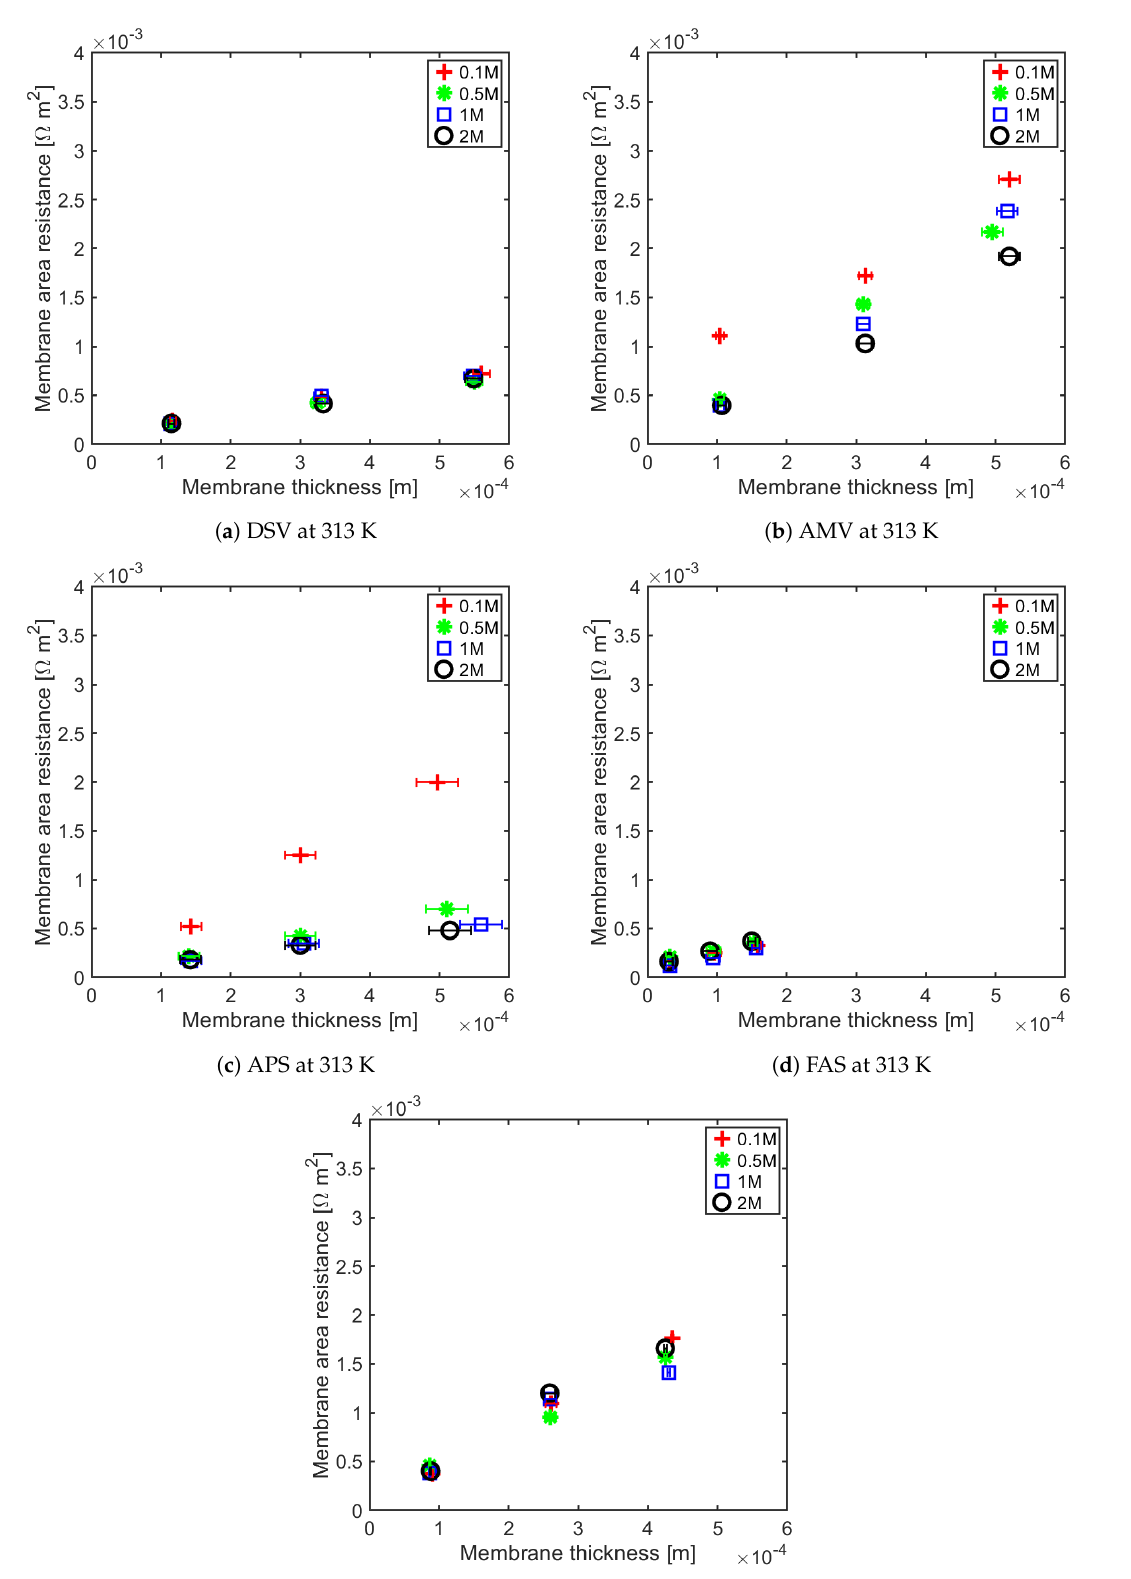
Figure 6. AEM resistance as a function of thickness for different concentrations at 313